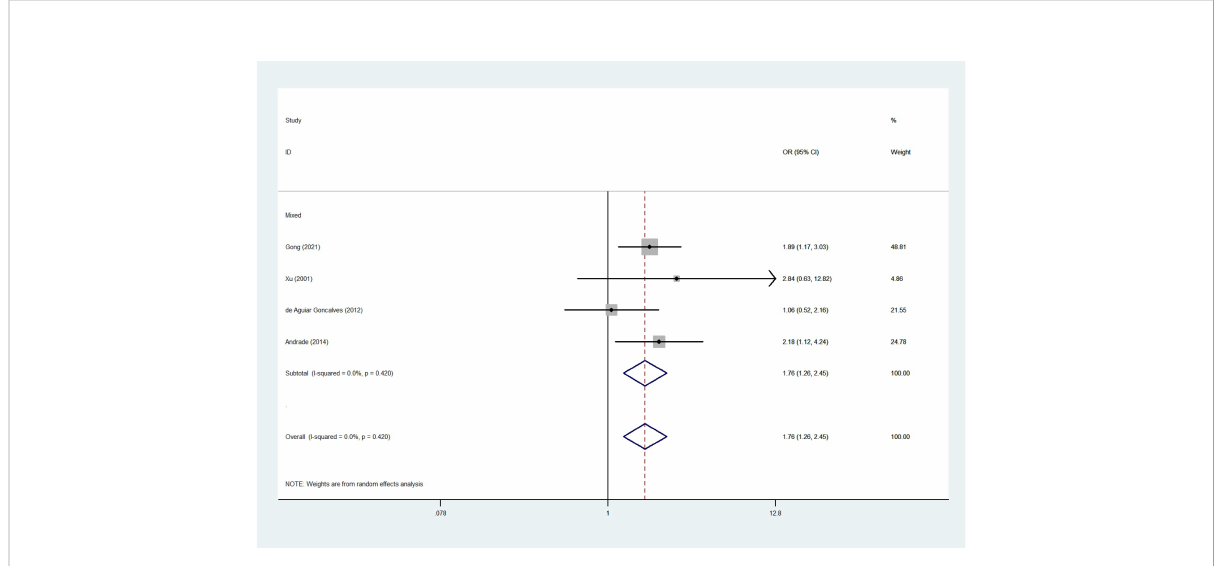
FIGURE 8 The relationship between cancer risk and the NQO1 gene rs1800566 polymorphism in mixed-race populations (CT vs. TT). There were signi fi cantly increased association between NQO1 polymorphism in Mixed population. The squares and horizontal lines correspond to the study-speci fi c OR and 95% CI. The area of the squares re fl ects the weight (inverse of the variance). The diamond represents the summary OR and 95%